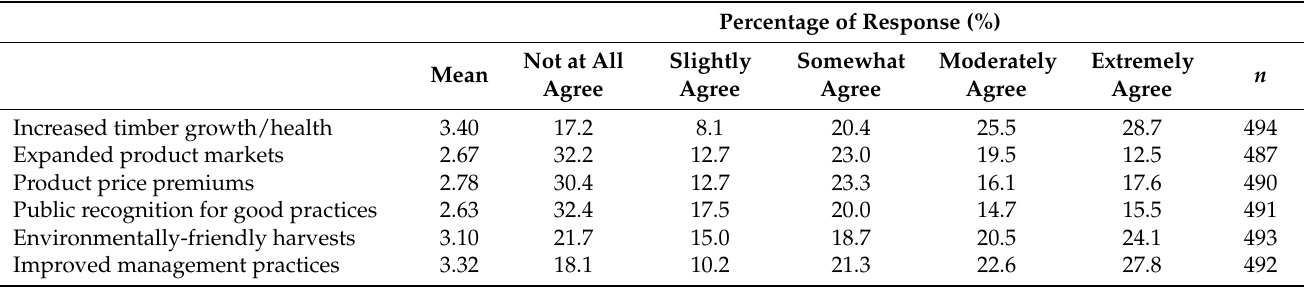
Table 2. Landowners’ agreement regarding perceived benefits associated with forest certification.